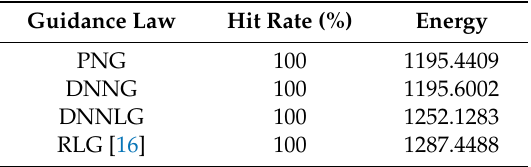
Table 4. Average energy for the 100 random initial conditions outside the range of the training data.